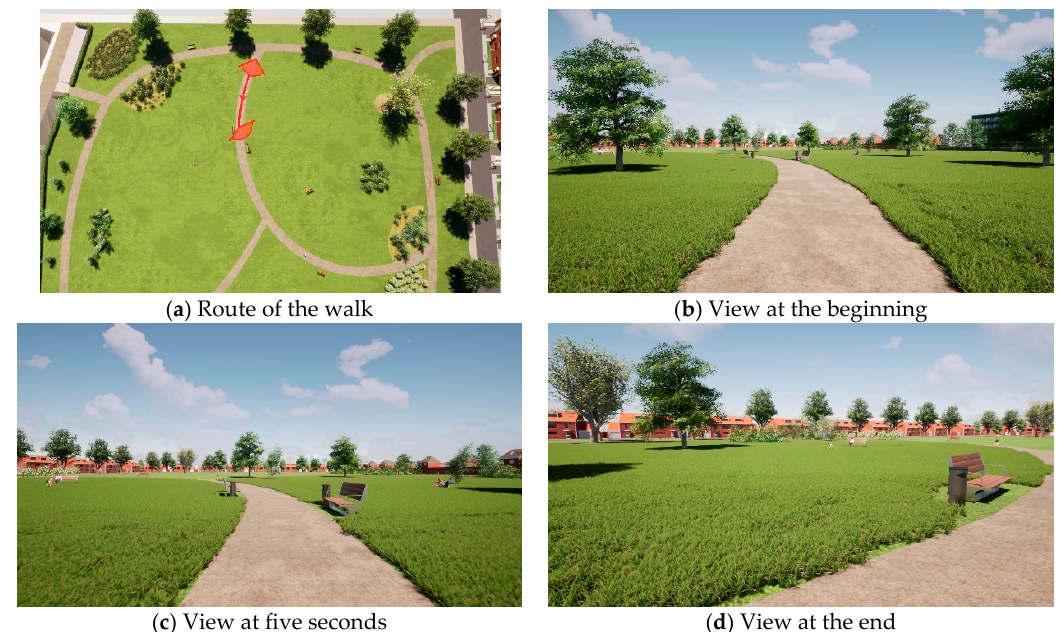
Figure 3. ( a ) Top view of the route of the walk; ( b ) Screenshot of video at the beginning; ( c ) Screenshot of video at five seconds; ( d ) Screenshot of the end of the video.